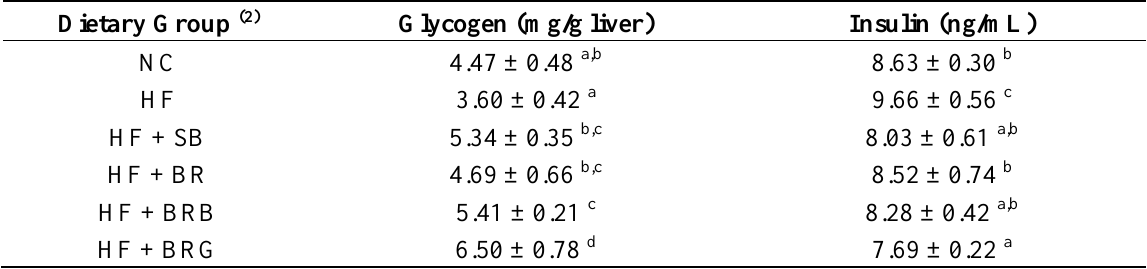
Table 4. Glycogen and insulin concentrations (1) in mice fed with high-fat-diet supplemented with rice fermented